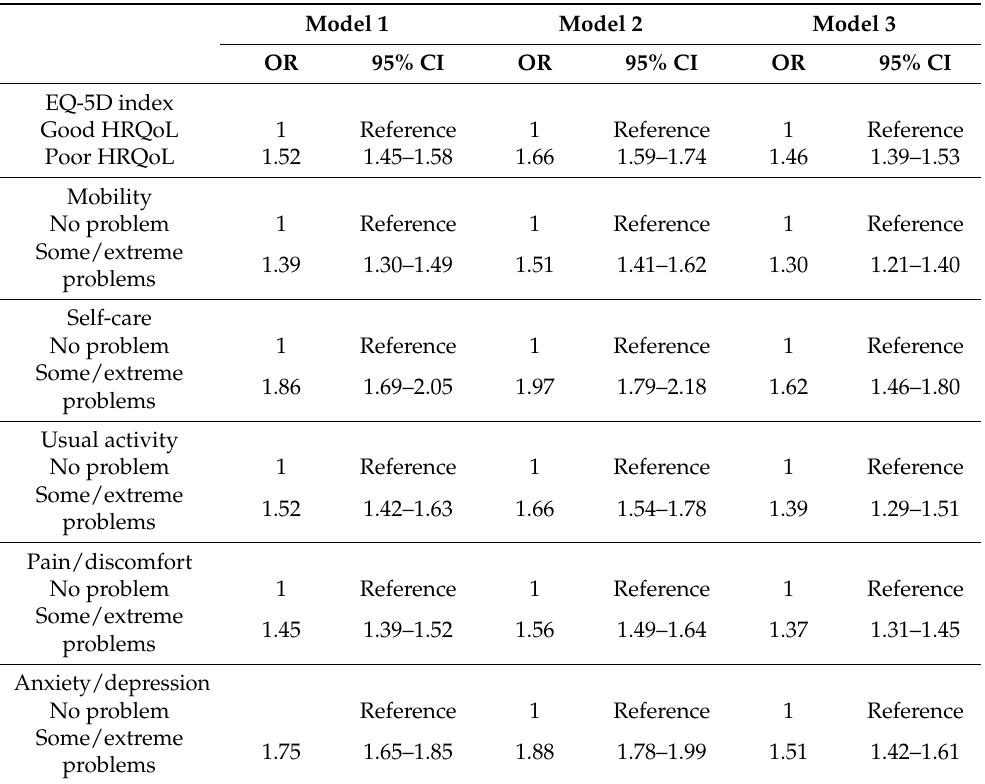
Note: The statistical models were controlled for demographics (Model 1), further controlled for socioeconomic variables (Model 2), and further controlled for physical and mental health-related variables (Model 3). Abbreviations: CI, confidence interval; EQ-5D, European Quality of Life Questionnaire Five Dimension; OR, odds ratio. A one-to-one propensity score matching identified 9563 caregivers and 9563 noncar- egivers matched for demographics and socioeconomic variables (Table 4). Similar to the unmatched analysis, caregivers versus noncaregivers had a higher frequency of diabetes